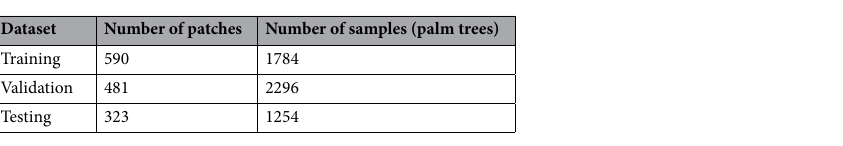
Dataset Number of patches Number of samples (palm